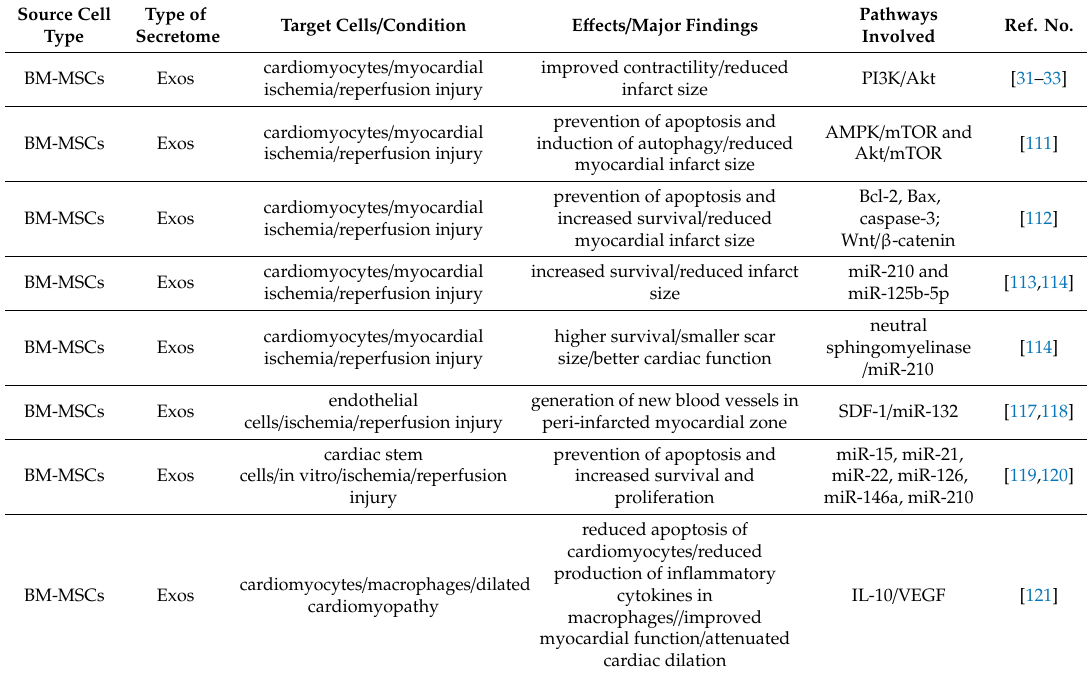
Table 5. Therapeutic potential of MSC-sourced secretome in myocardial